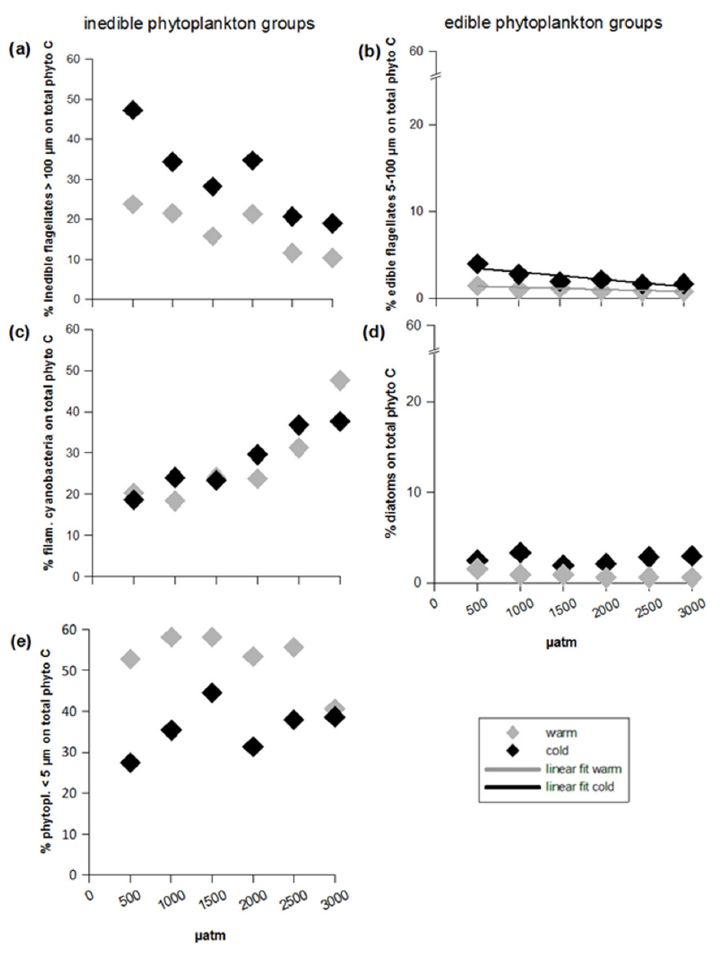
Figure 4. Phytoplankton relative contributions to total carbon during the first period, divided into inedible (left side) and edible groups (right side): ( a ) % inedible flagellates >100 μ m on total phytoplankton C, ( b ) edible flagellates 5–100 μ m on total phytoplankton C, ( c ) % filamentous cyanobacteria on total phytoplankton C, ( d ) % diatoms on total phytoplankton C, ( e ) % phytoplankton <5 μ m on total phytoplankton C. Symbol attribution to treatment combinations (temperature treatments + CO 2 target values) are given in the legend. Fitted lines indicate a significant response of phytoplankton relative contribution to CO 2 at the different temperature levels.